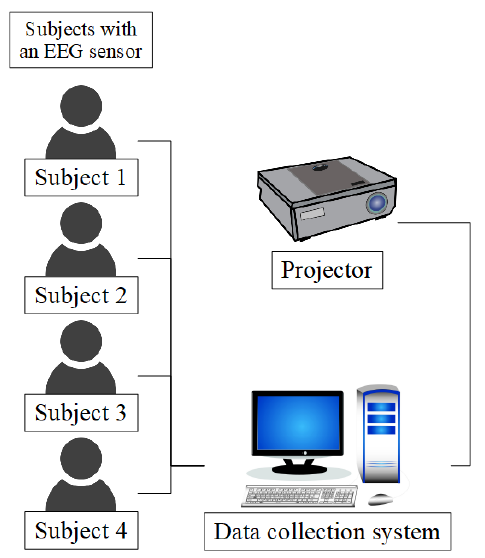
Figure 4. Data collection system structure.